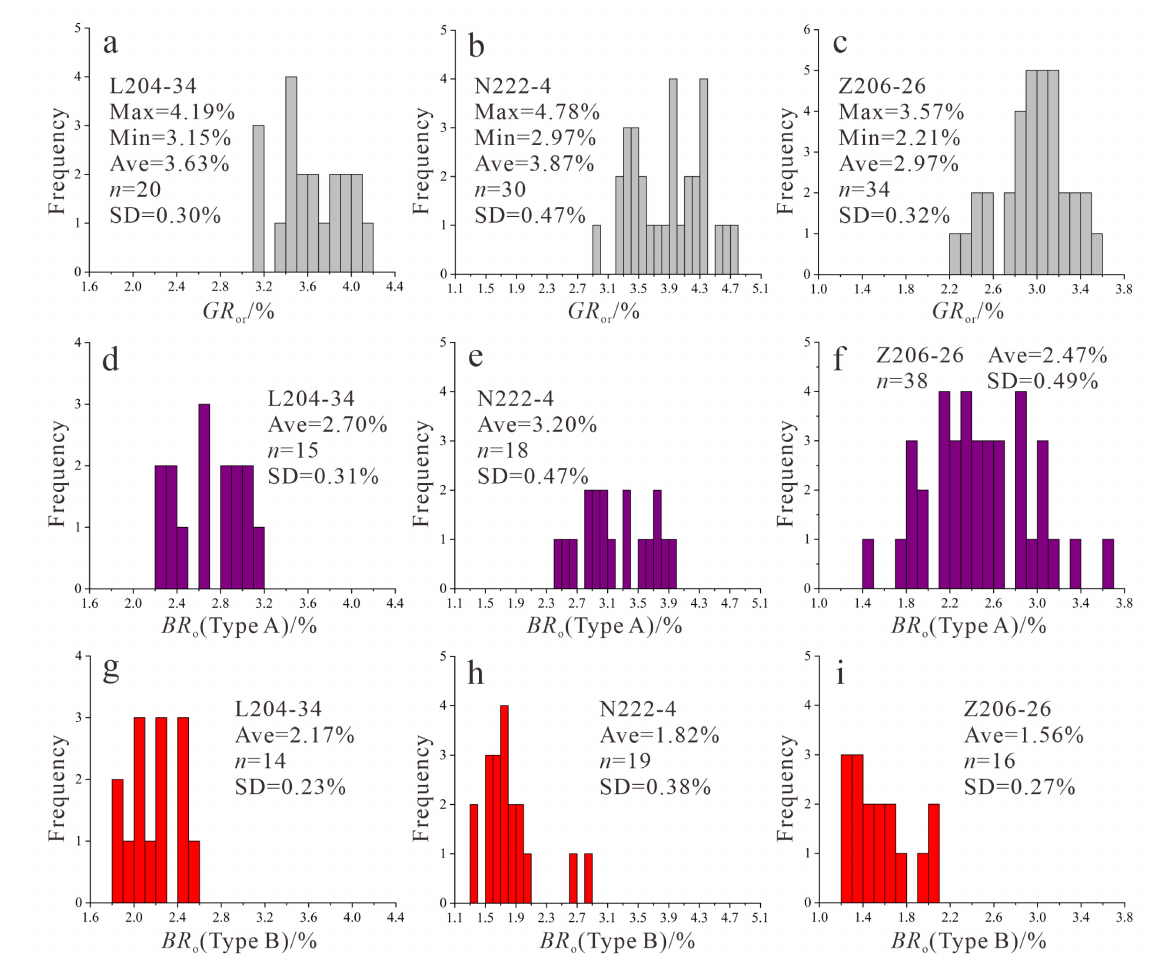
Figure 5. Comparison of the random reflectance of non-granular graptolites ( a – c ) and solid bitumen (Type A: d – f ; Type B: g – i ) in samples L204-34, N222-4 and Z206-26 on sections perpendicular to bedding. Max: maximum value; Min: minimum value; Ave: average value; n: number of measuring points; SD: standard deviation.